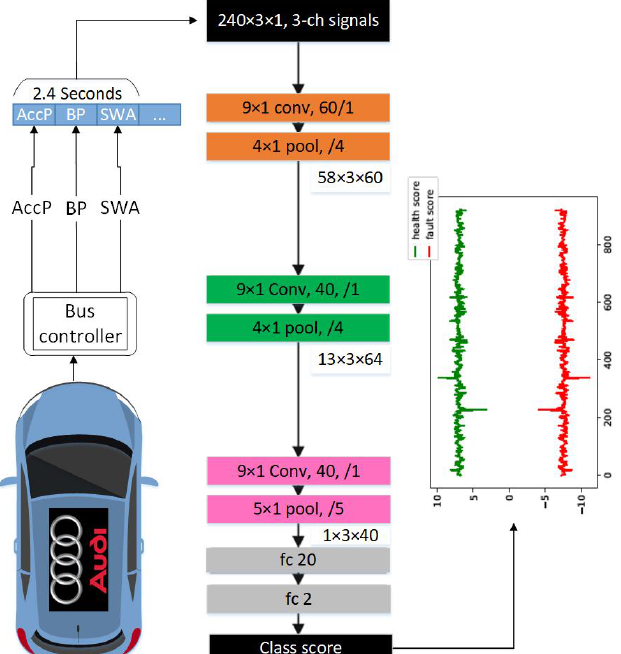
Figure 5. The convolution structures of the suggested 1D CNN adaptive configuration [26], e.g., “9 × 1 conv, 60, /1” indicates a convolutional layer with 60 kernels, size 9 × 1, stride 1; a box labeled “4 × 1 pool, /4” implies a max pooling layer with a size of 4 × 1, stride 4; ‘fc 20’ is a fully connected layer with the output dimension of 20. The numbers across boxes are the prior layers’ output